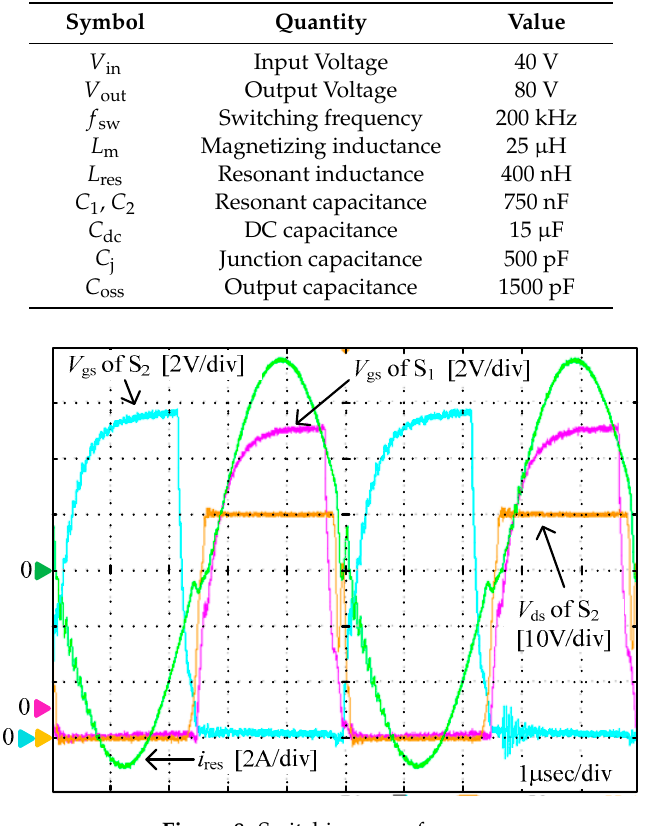
Table 2. Experimental parameters.